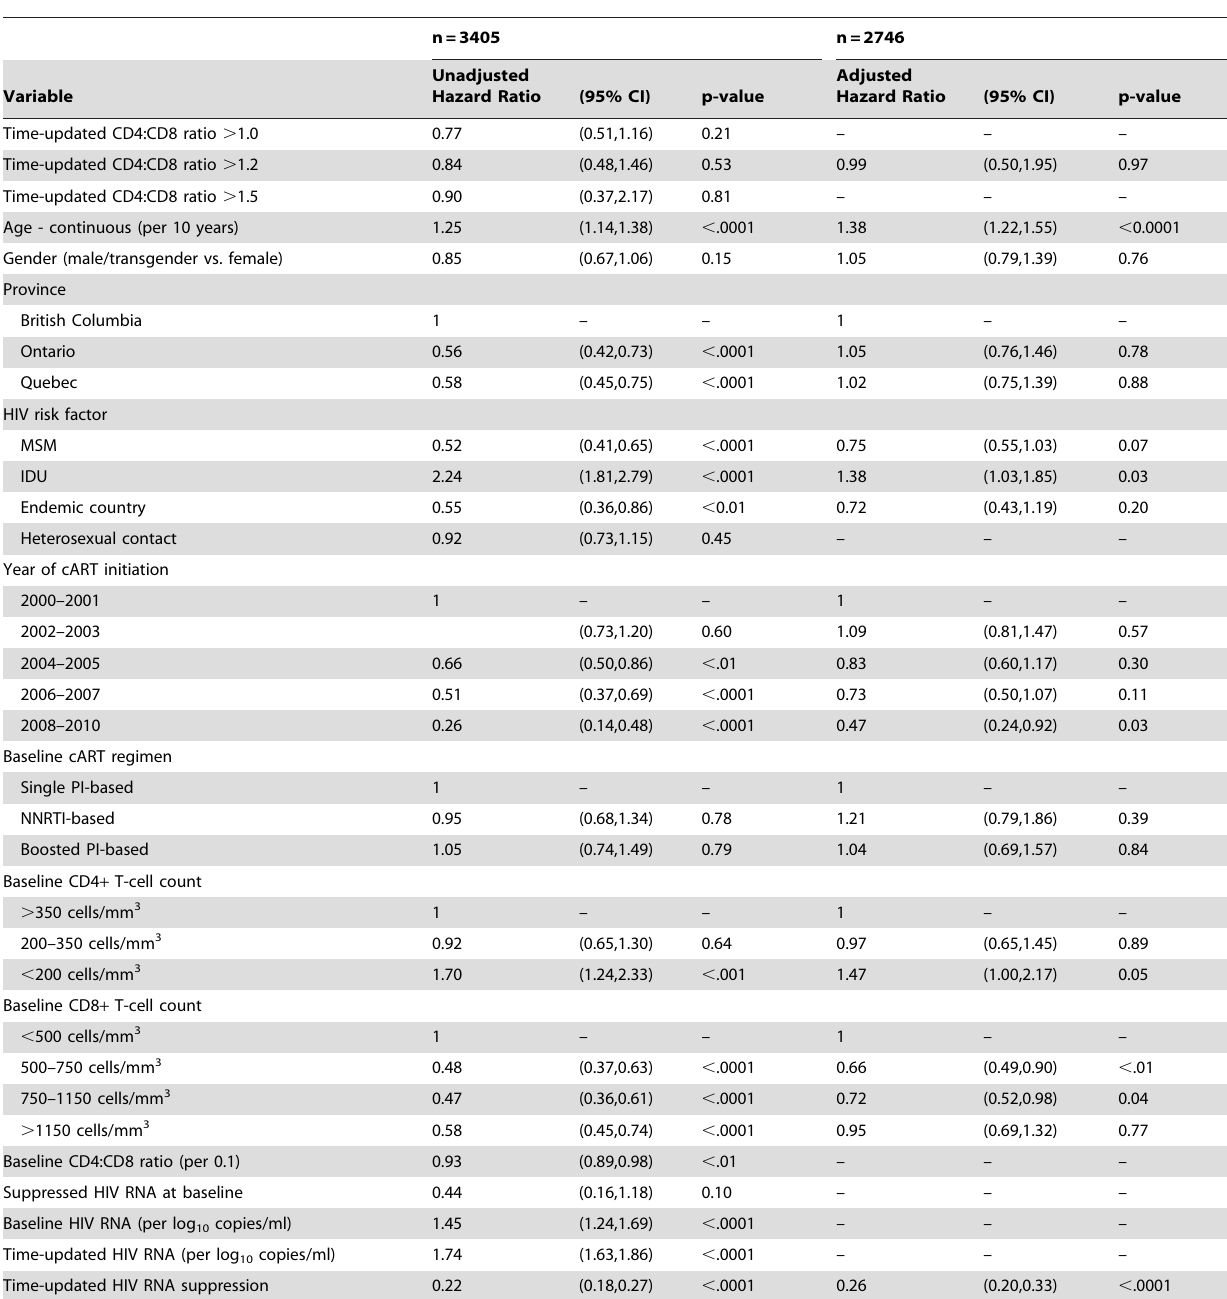
Table 3. Univariable and multivariable proportional hazards model for time to ADI or